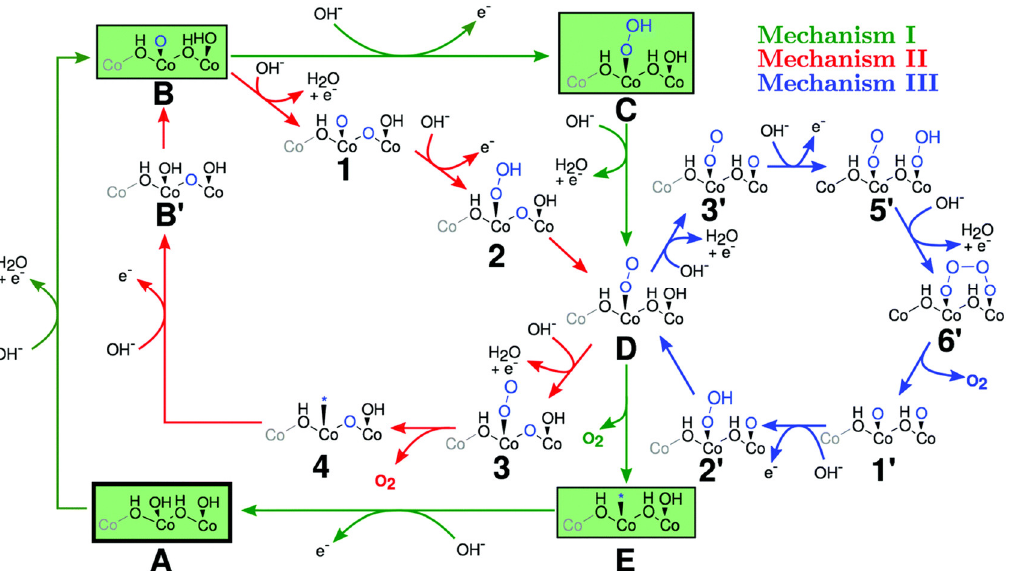
Figure 31. Three mechanisms in competition for water oxidation. The four intermediates frequently reported in the literature are highlighted in green. (Reprinted from ref. [191] with permission from Physical Chemistry Chemical Physics © 2020, Royal Society of Chemistry).